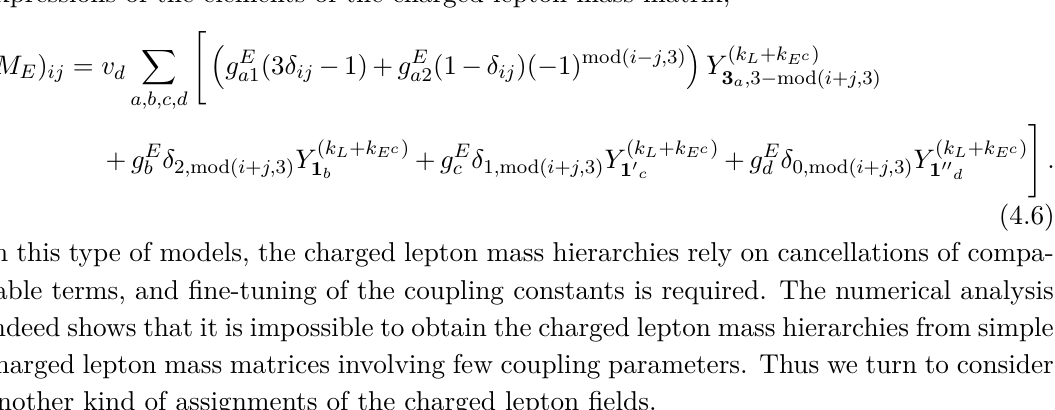
Table 1 . Summary of modular forms of level 3 up to weight 8, the subscript r denote the transfor- mation property under A forms transforming in the representation 3 of A expressions of the elements of the charged lepton mass